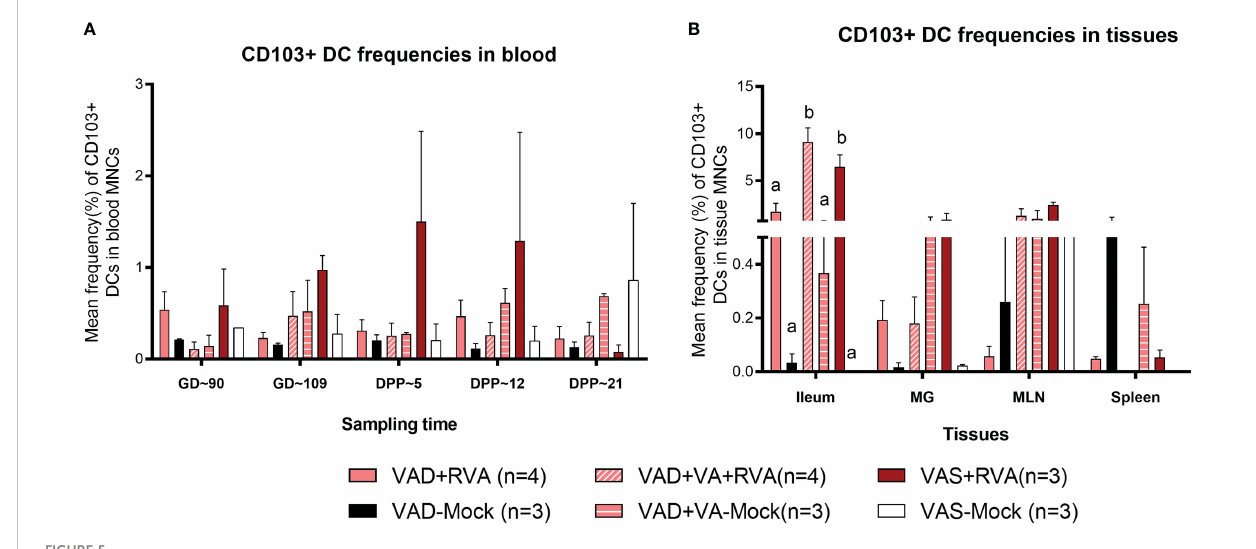
FIGURE 5 Analysis of CD103 + DCs in blood and tissues using fl ow cytometry. Mean frequencies of CD103 + dendritic [CD103 + DCs] among blood MNCs (A) and tissues (B) . Letters a and b indicate signi fi cant differences among treatment groups (mean ± SEM) at each time point. Statistical analysis was performed using two-way ANOVA with repeated measures and Tukey-Kramer test for multiple comparisons, P ≤ 0.05. (GD, gestation day; DPP, day post-partum; VAD, vitamin A de fi ciency; VAS, Vitamin A suf fi cient; VA-vitamin